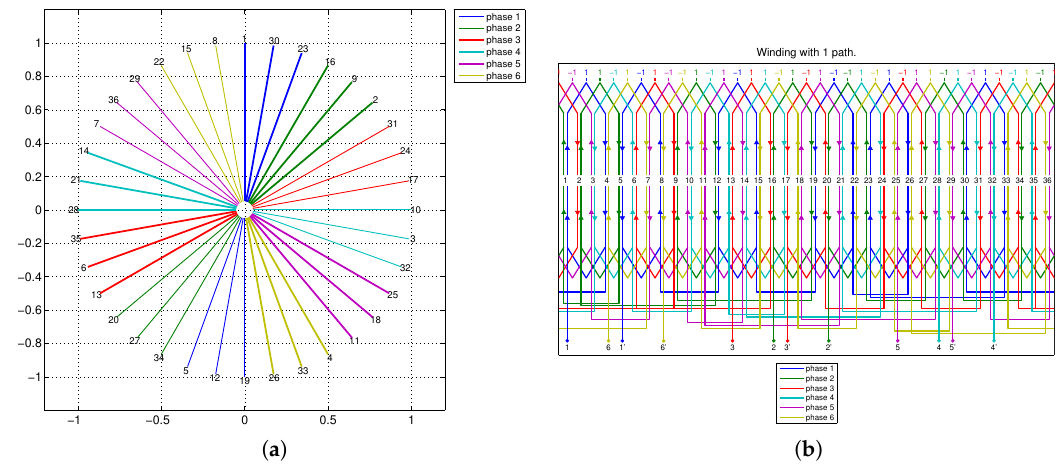
Figure 11. ( a ) EMF star and ( b ) winding scheme of a double layer reduced symmetrical configuration with N = 36, m = 6, p = 5 and q = 3 / 5